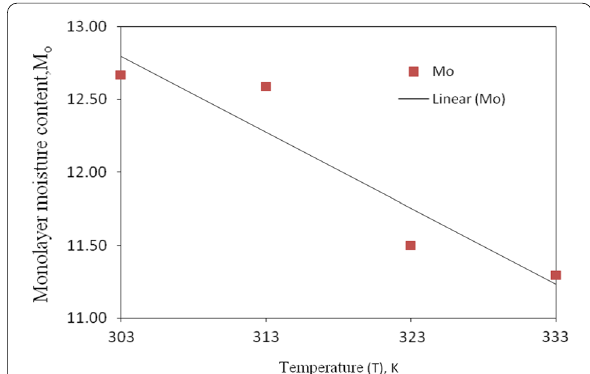
Fig. 5 Variation of monolayer moisture content ( M o ) with temperature ( T ) of karaya gum